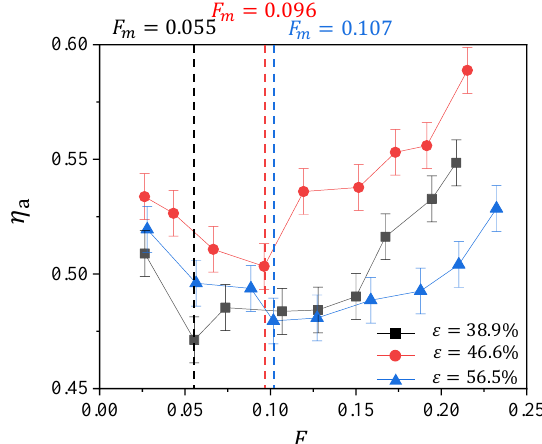
Figure 8. Variation of average cooling efficiency η a with blowing ratio F for different porosity ε